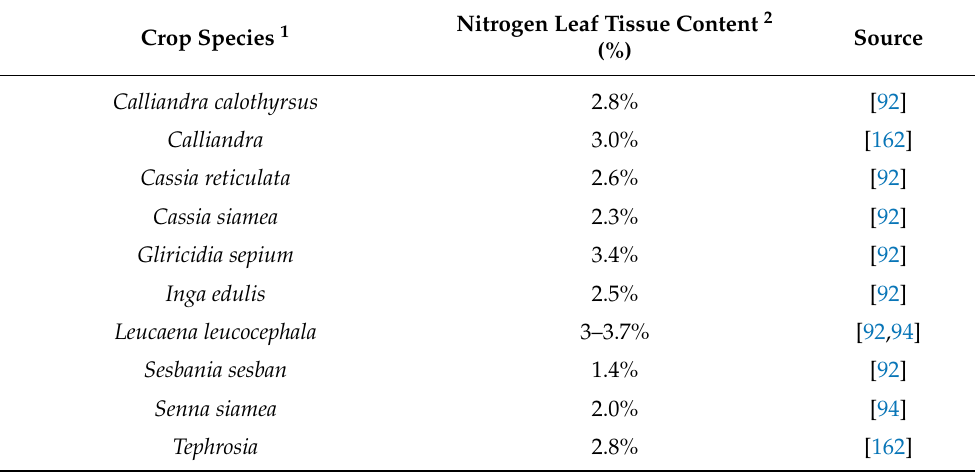
Table 3. Percent Nitrogen (N) tissue content from the foliage of several agroforestry